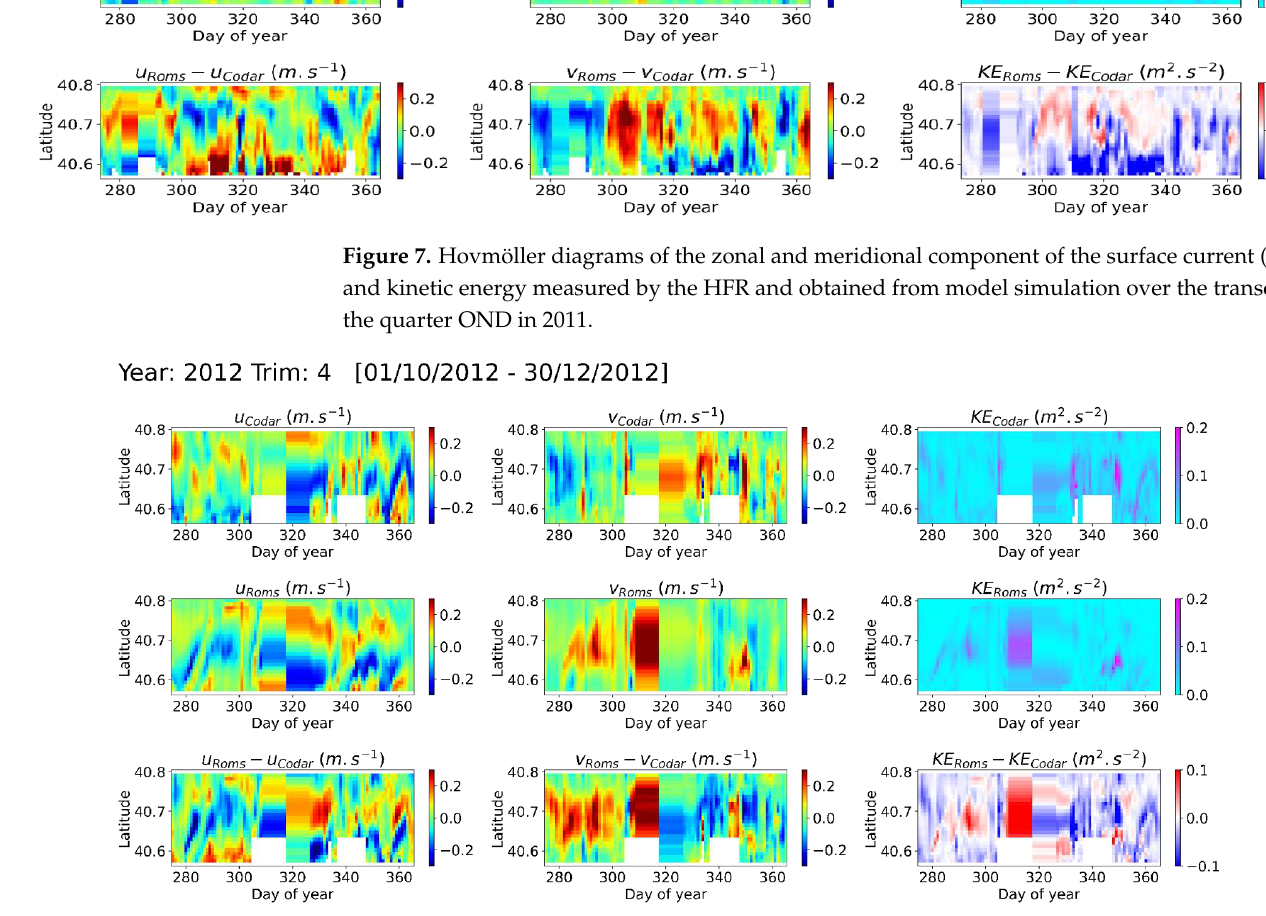
Figure 8. Hovmöller diagrams of the zonal and meridional component of the surface current (cm/s) and kinetic energy measured by the HFR and obtained from model simulation over the transect for the quarter OND in 2012.